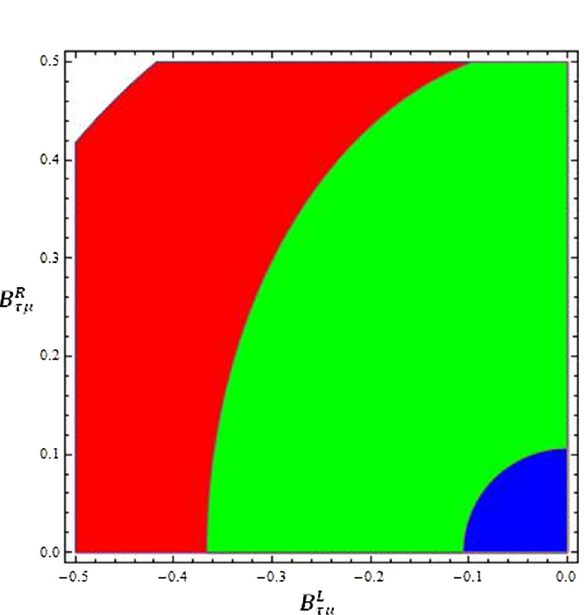
Fig. 4 The parameter space allowed by the experimental upper limits mentioned at Eq.